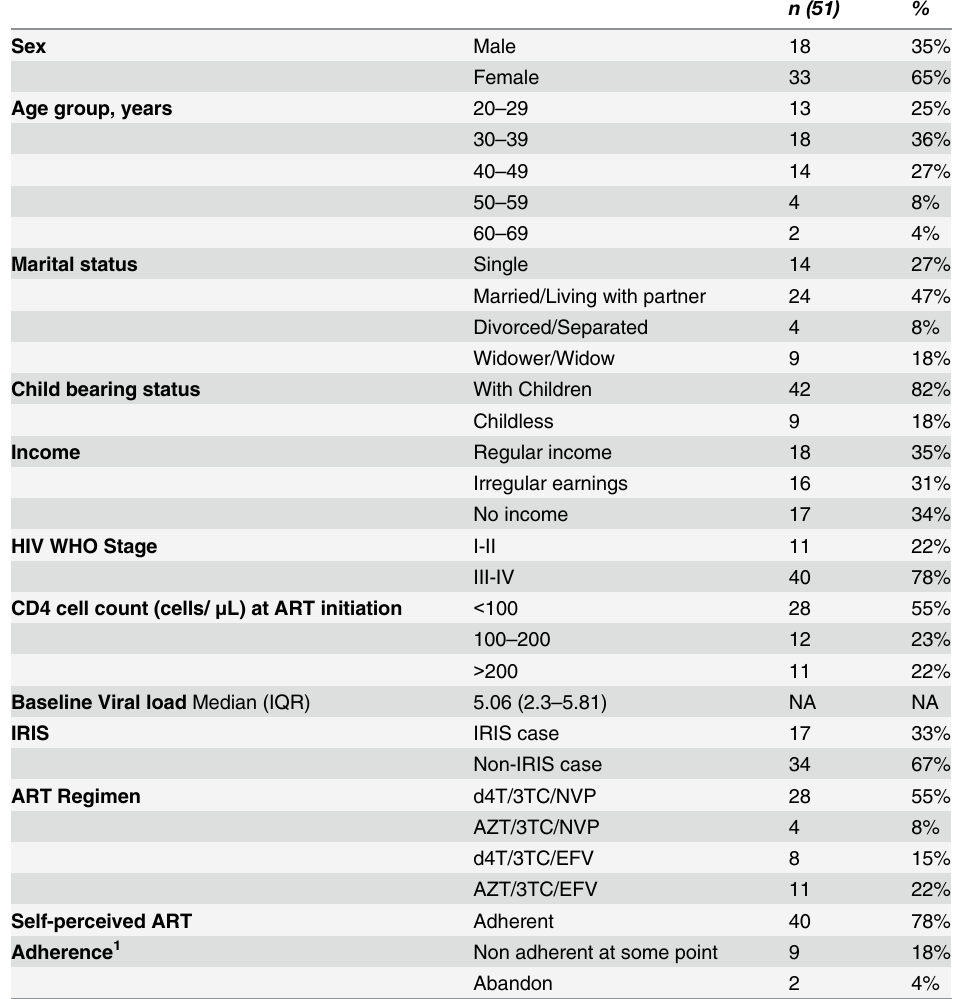
Table 2. Participant